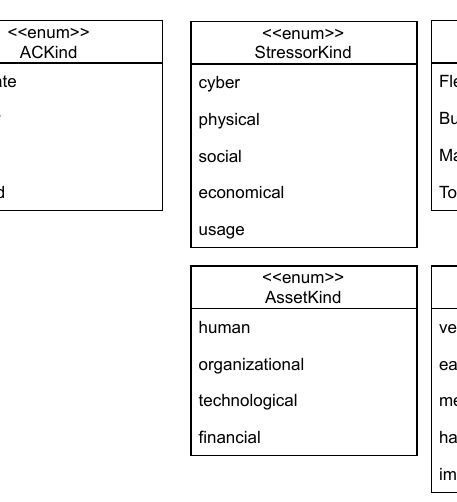
Figure 5. The cyber-resilience domain model—the datatypes package.